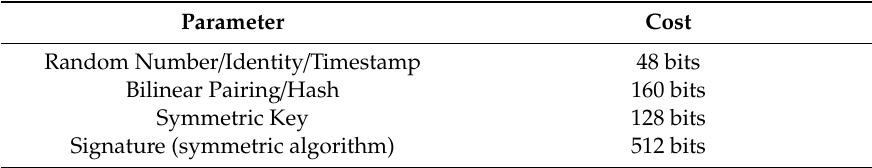
Table 6. Cost of each parameter exchanged in bits.